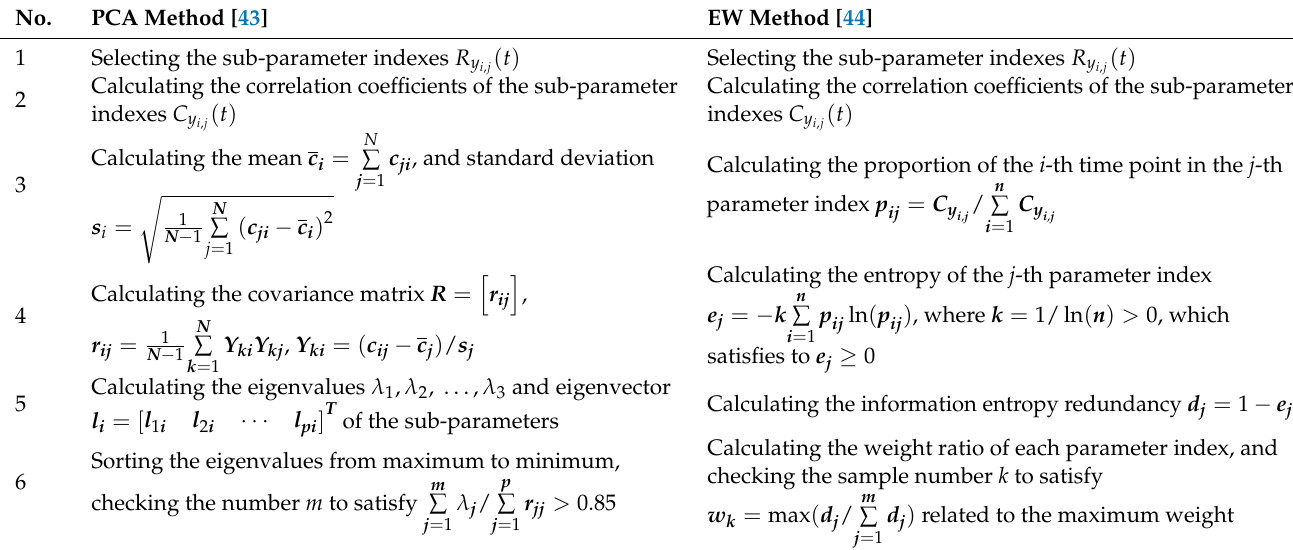
Table 3. Steps of Principal Component analysis and Entropy-weight